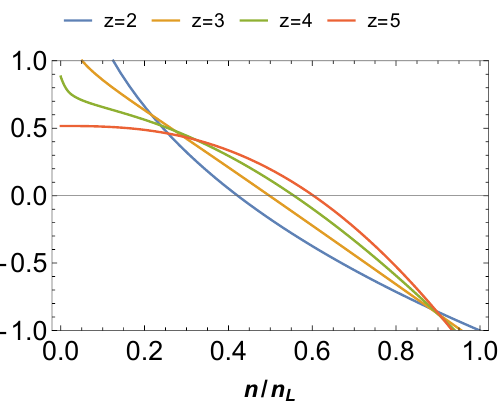
Figure 5. Variation of the characteristic speed (cid:21) 2 across a rarefaction wave pro(cid:12)le parametrised by n for d = 3 and di(cid:11)erent values of z